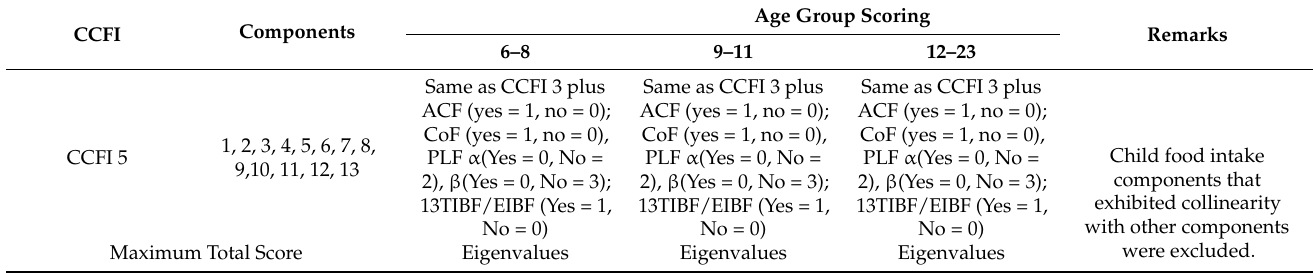
Table A1. Components and Criteria Applied for CCFI 5 Construction and